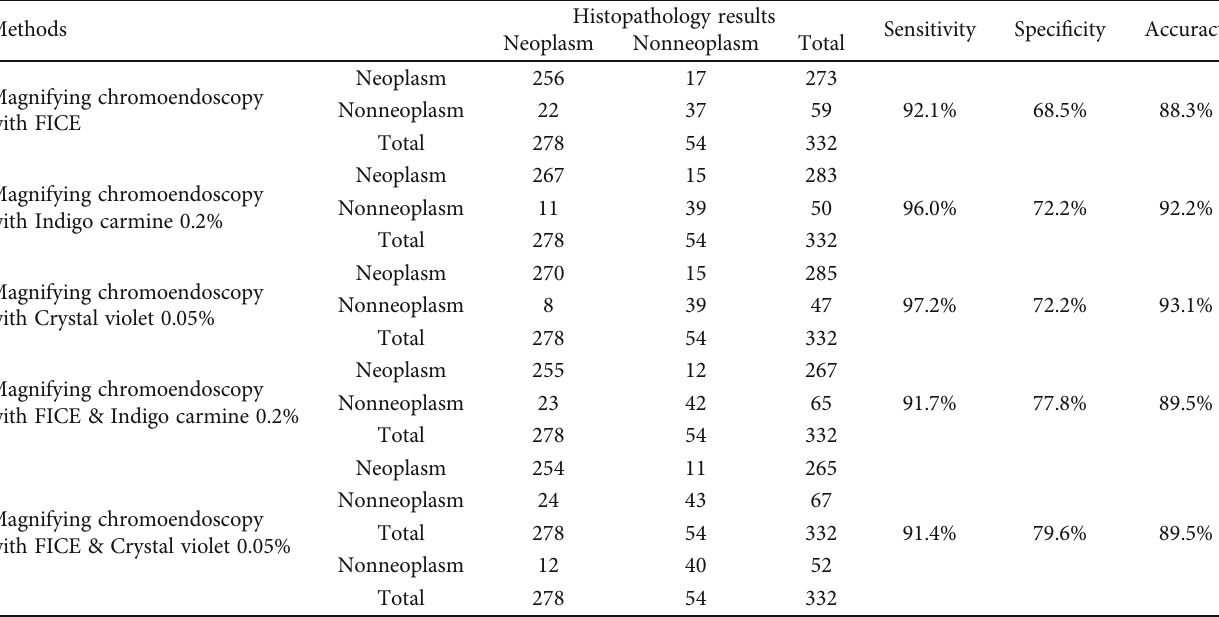
Table 5: The di ff erential diagnostic value of neoplastic and nonneoplastic polyps of magnifying chromoendoscopy in histological prediction of colorectal polyps.